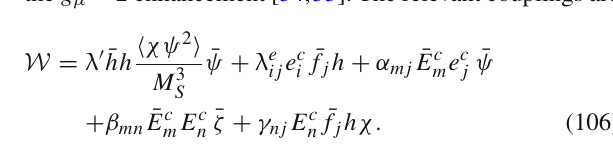
Fig. 6 Feynman diagram for the contribution of the vector-like pair in the g μ − 2 process the g μ − 2 enhancement [54,55]. The relevant couplings are